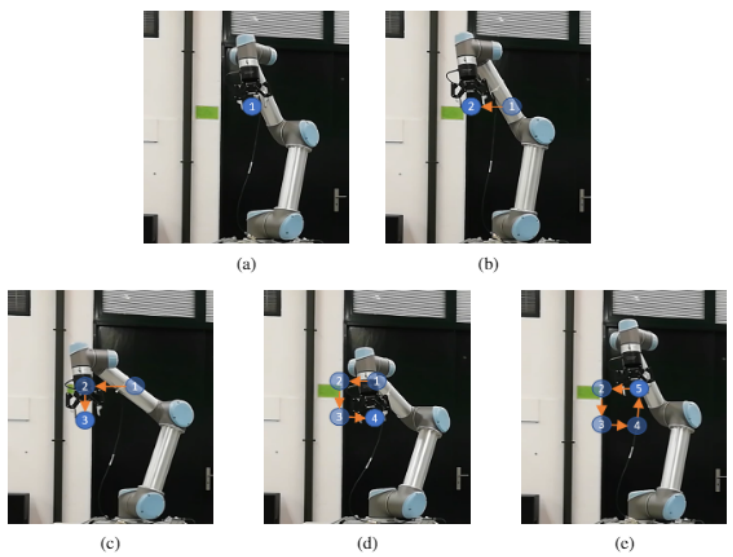
Figure 7. UR5 path execution (square): ( a ) robot at initial point. ( b ) Robot at second point. ( c ) Robot at third point. ( d ) Robot at fourth point. ( e ) Robot at final